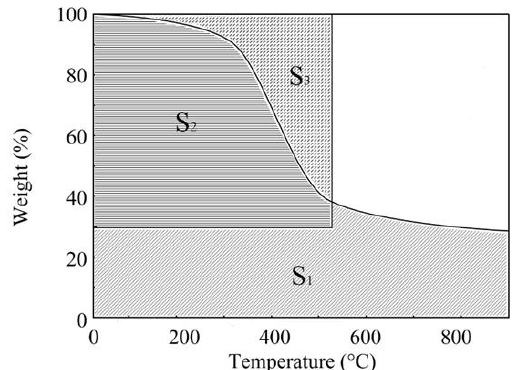
Figure 14. Doyle’s proposition for the calculation of the integrated program decomposition temperature (IPDT). Table 2. Thermal stability parameters of polysulfone (PSF)/epoxy blends.